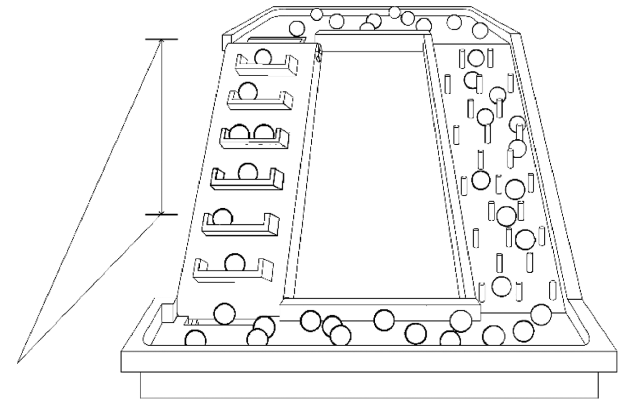
FIG. 2. Model of a conveyor belt used to establish an analogy between the transformation of gravitational energy in the con- veyor belt circuit and the transformation of electric energy in an electric